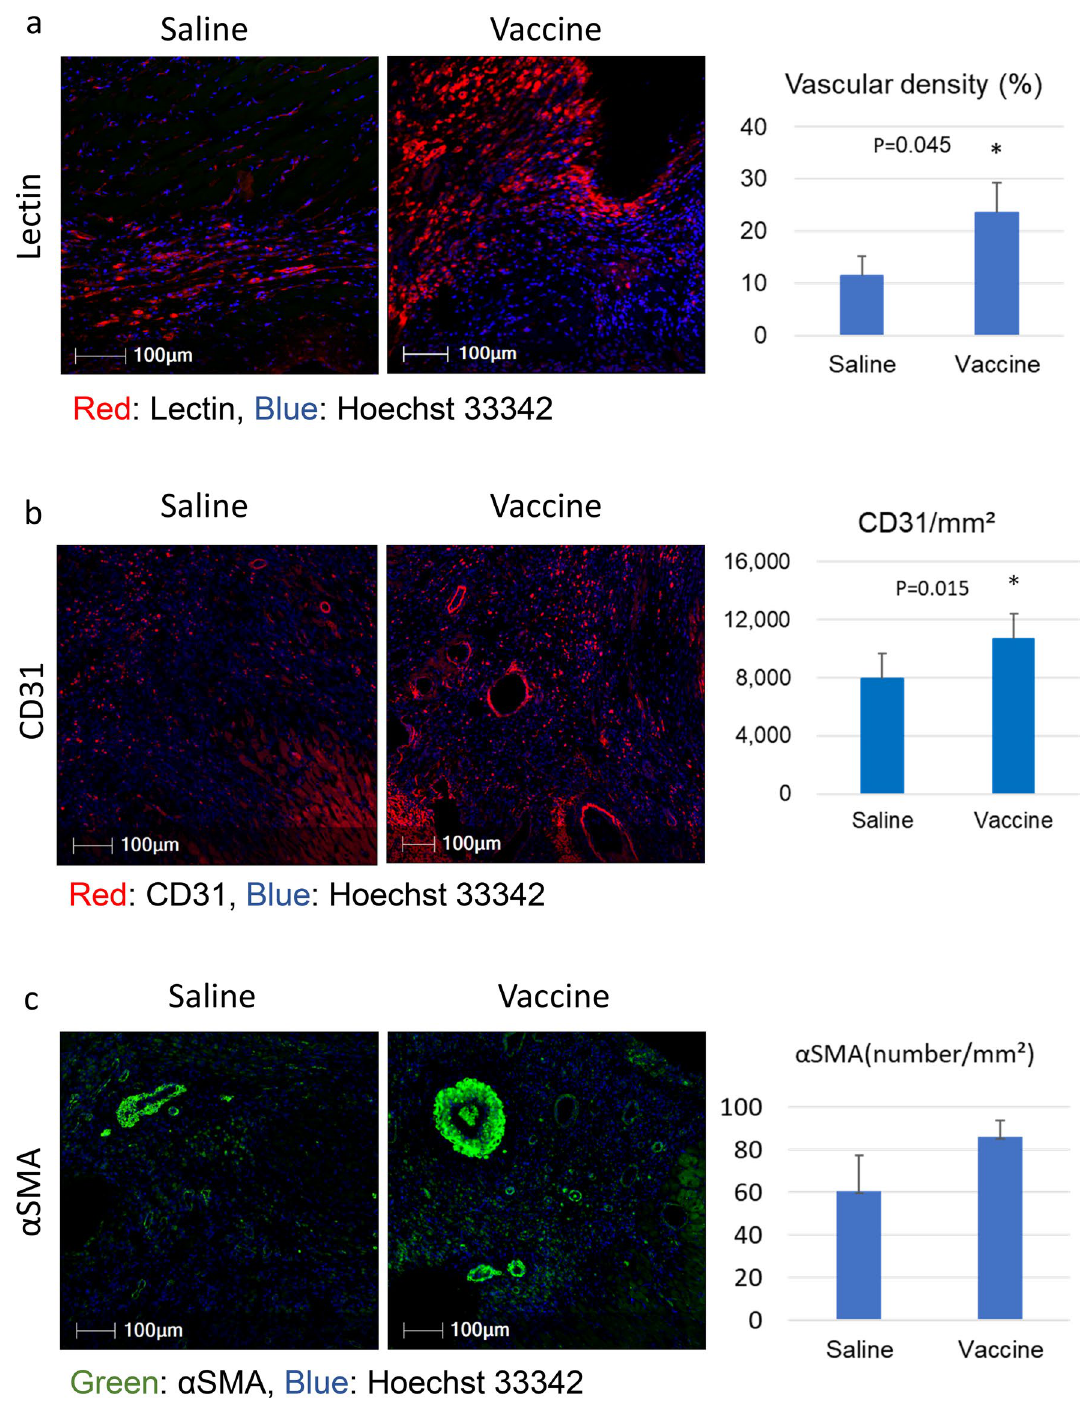
Figure 4. sEH vaccine treatment induced neovascularization in ischemic border area. ( a ) Immunofluorescent staining of ( a ) lectin, ( b ) CD31, and ( c ) α-smooth muscle actin. The nuclei were visualized using Hoechst 33342. Sections of hearts from the saline group (n = 5–7) and the vaccinated group (n = 5) at day 7 were evaluated. Scale bar = 100 μm. The border areas between infarcted and non-infarcted sites were randomly measured at five locations. Cells labeled with CD31, a marker of endothelial cells, were counted (cells/mm 3 ). *P < 0.05 Lectin was also used to assess vascular density (%). *P <